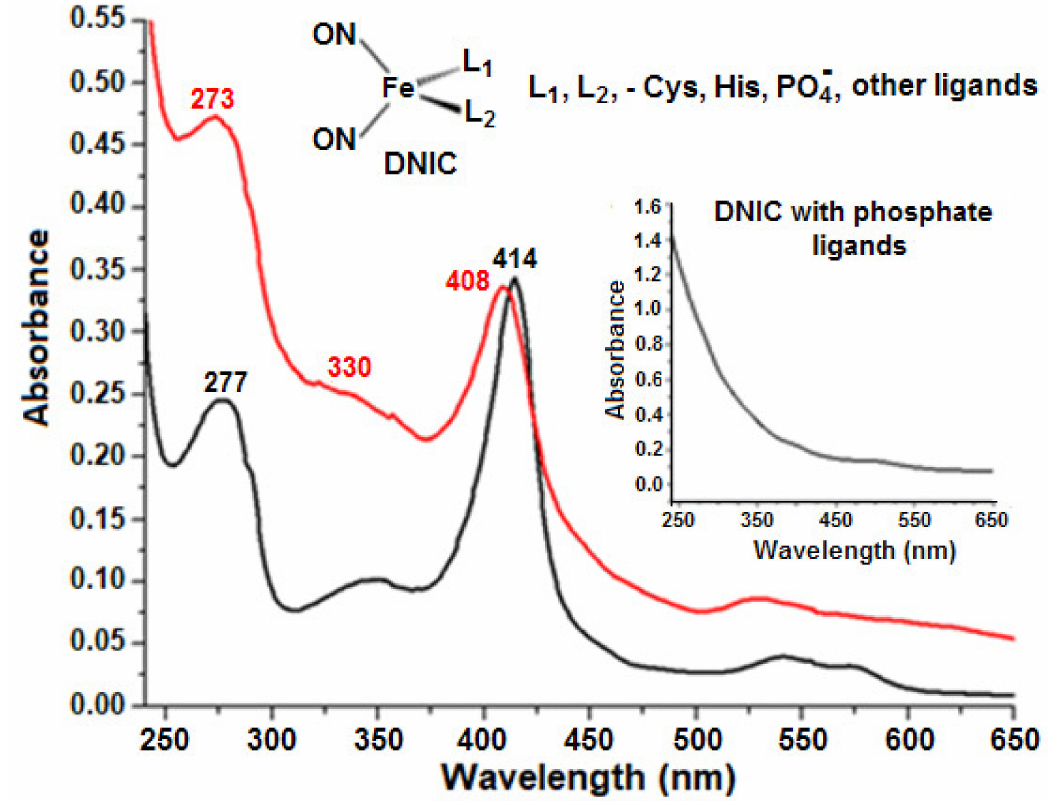
Figure 7. Absorption spectra of recombinant Lb a —the black curve—and its complex with DNIC—the red curve. The insert shows the spectrum of dinitrosyl iron complexes (DNICs) with phosphate